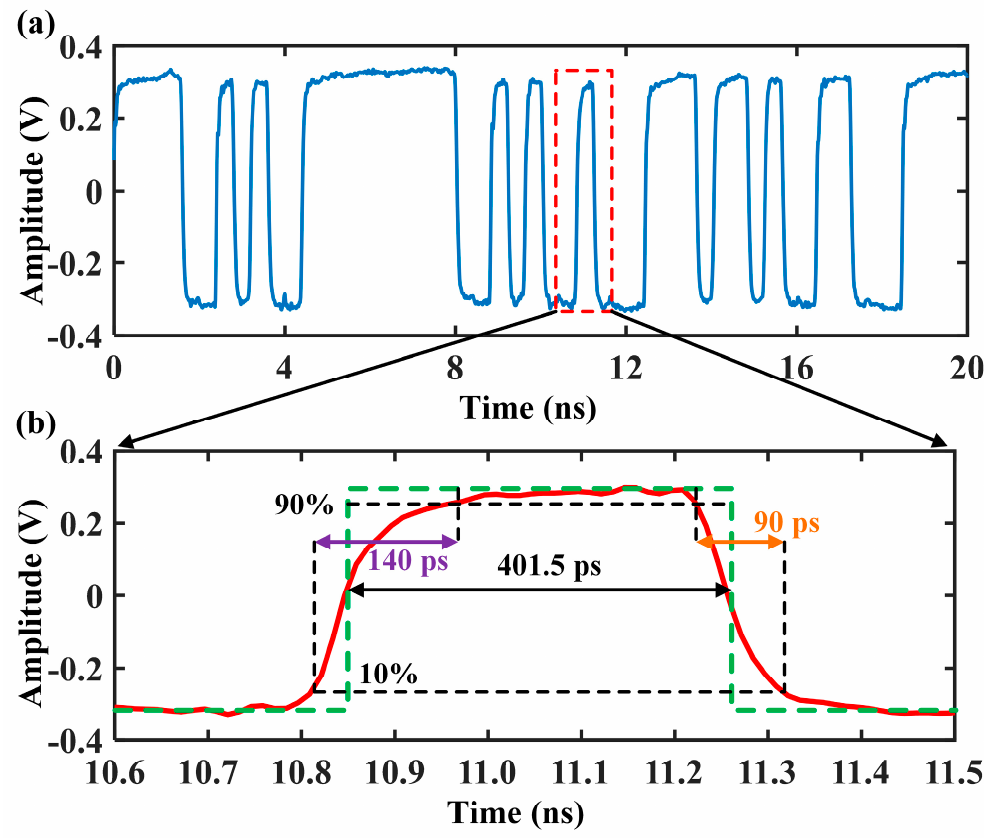
Figure 2. The measured optical signal under test after optoelectronic conversion via a photodetector at ( a ) a random 20 s period, and ( b ) the zoom-in view measured from 10.6 to 11.5 ns.